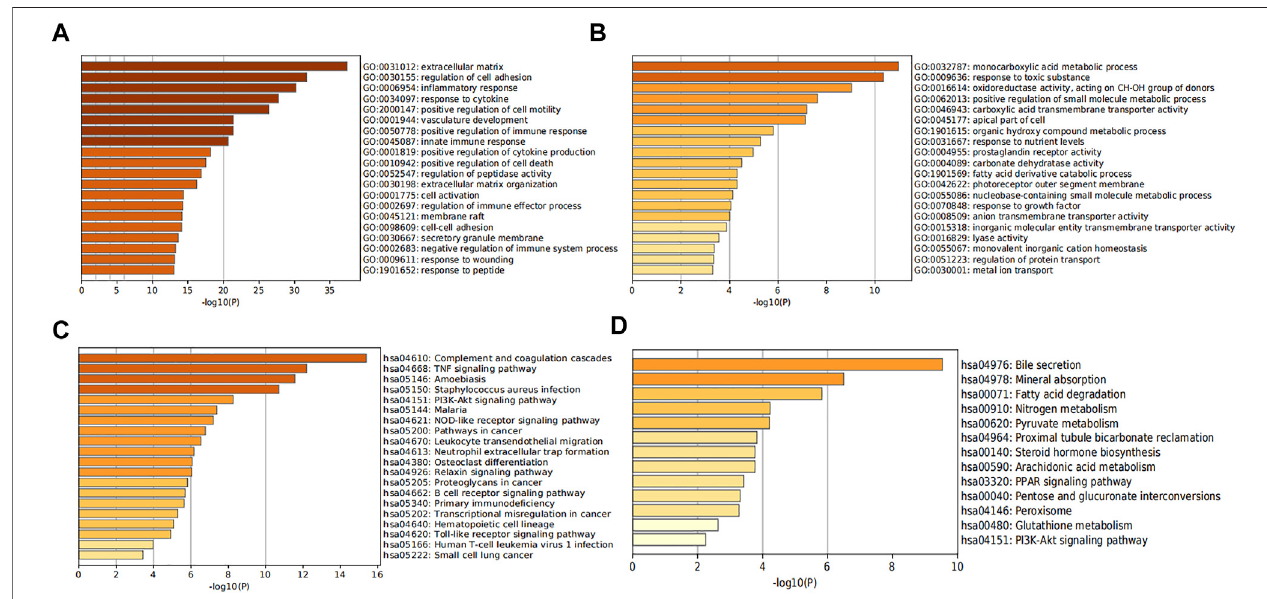
FIGURE 3 | Analysis of functional enrichment in DEGs. The bar graphs show the top 20 results of the up-regulated gene (A,C) and down-regulated gene (B,D) enrichment analysis. p -value is displayed in color.